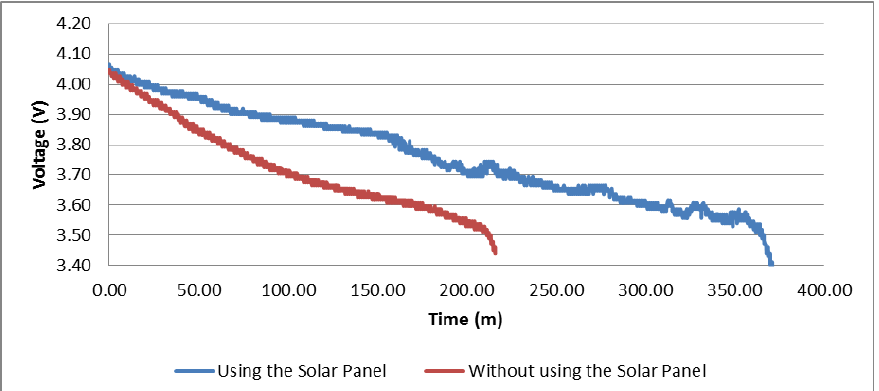
Figure 7. Battery draining in test 1 and 2.